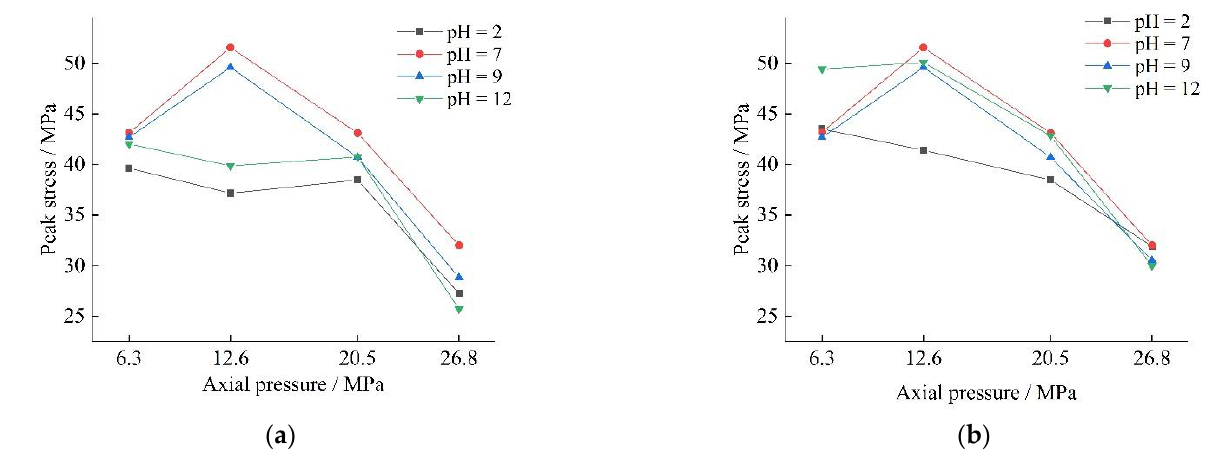
Figure 8. The trend of peak stress. ( a ) initial peak stress; ( b ) the maximum of peak stress.